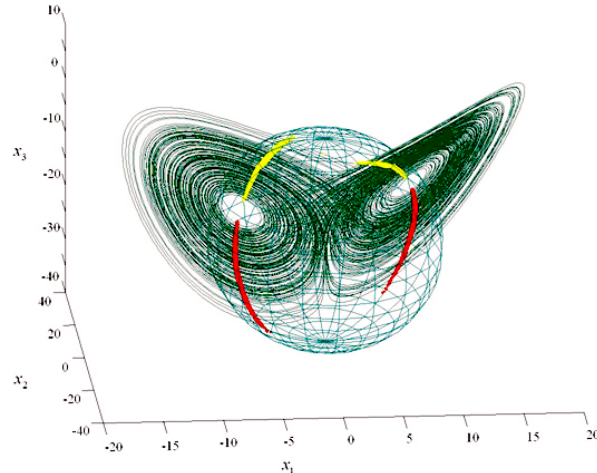
Fig. 1. Ellipsoid of Casimir extremes intersecting the attractor in four regions: the two stripes in the semi-space x 2 < 0 represent the set of maxima and the remaining two ( x 2 > 0) the minima. Figure from Pelino and Maimone (2007), copyright American Physical